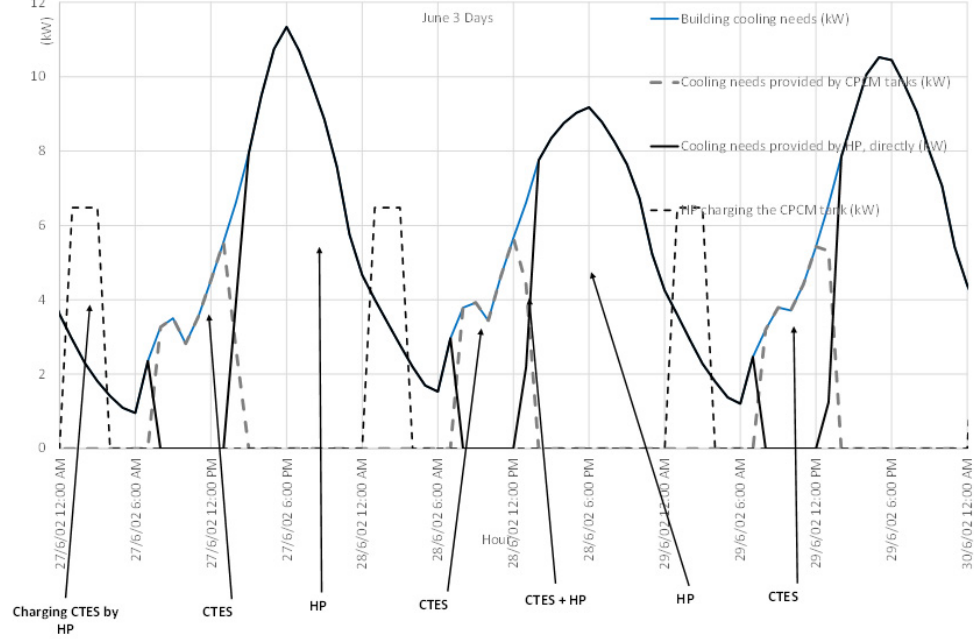
Figure 8. Indicative system operation for three days in June (cooling